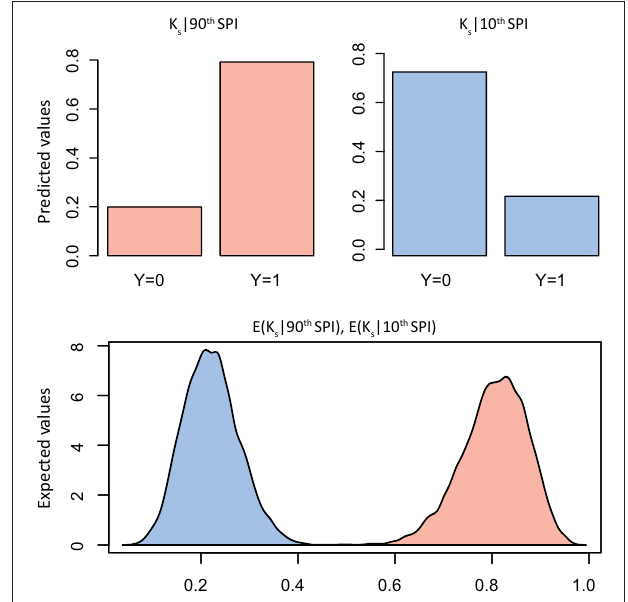
FIGURE 4 | Bayes simulation of quantities of interest. Predicted probability (bar plot) and expected probability (density plot) of presence [1] − absence [0] of W r pointer years (Y) at the 90 th (red) and 10 th (blue) percentile of the Standardized Precipitation Index (SPI). E(W r |90 th SPI), mean = 0.53( ± 0.09), 2.5% = 0.34, 97.5% = 0.70; E(W r |10 th SPI), mean = 0.46( ± 0.07), 2.5% = 0.33, 97.5% = 0.60.